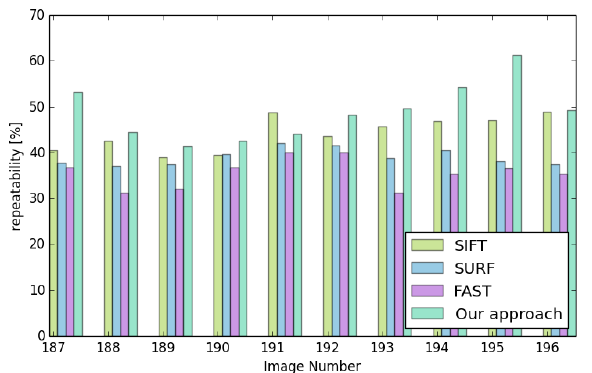
Figure 9. Repeatability of the extracted feature points